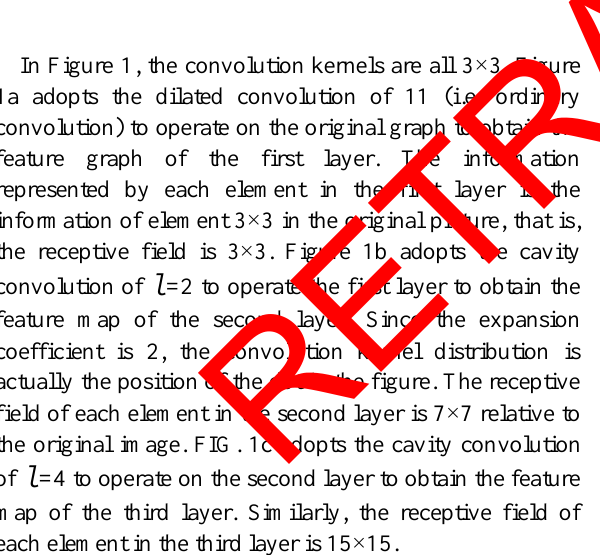
Figure 1. Expansion of receptive field due to dilated